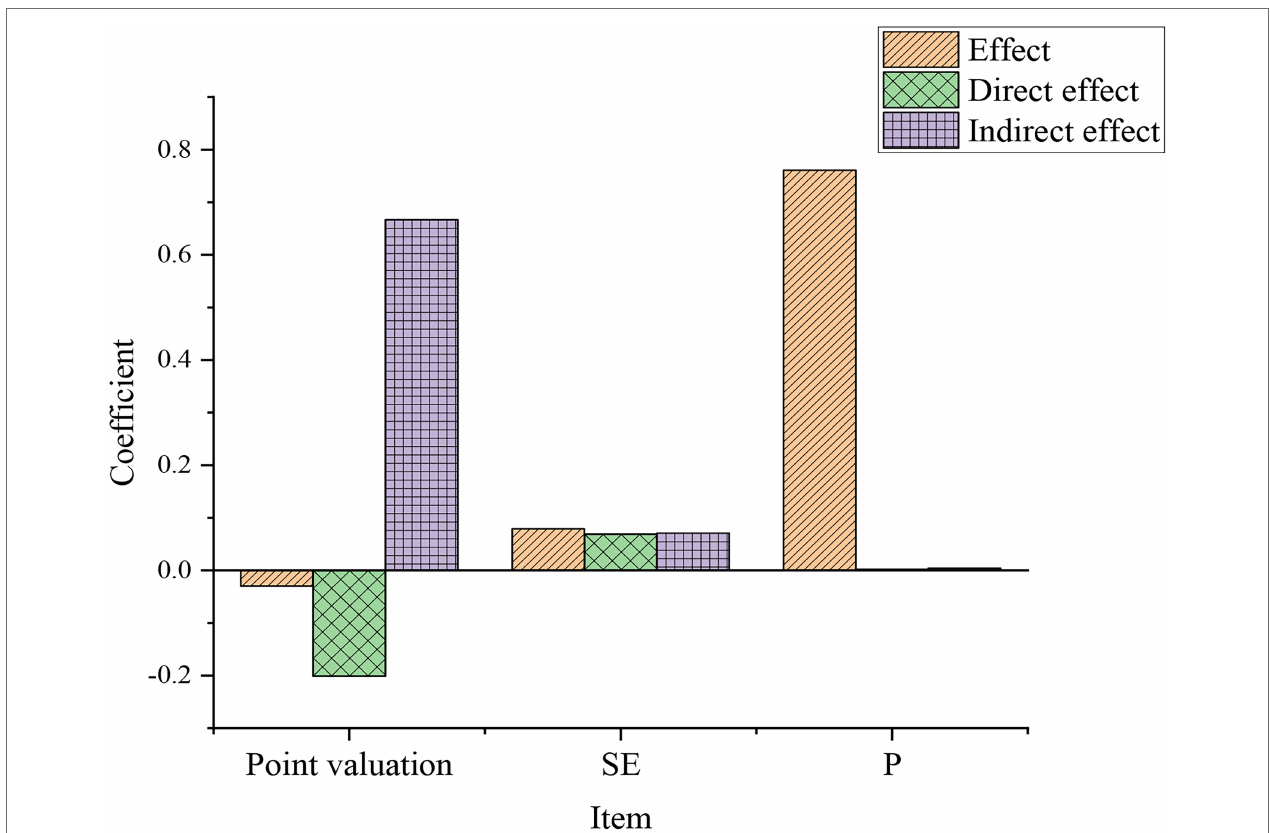
FIGURE 6 | Estimation of the mediating role of music